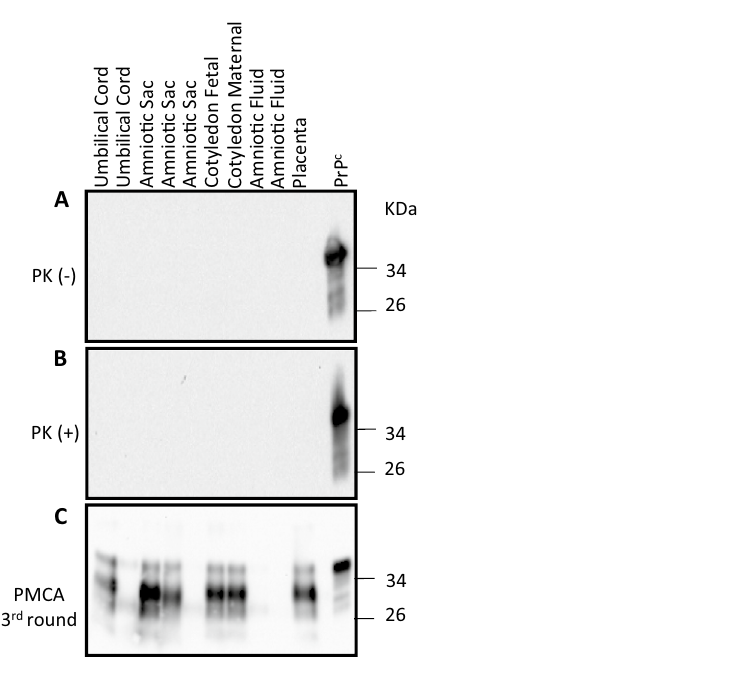
Figure 2. Identification of PrP Sc in white-tailed deer gestational tissues and fluids by western blot and PMCA. Western blot analysis of representative gestational tissue samples prior ( A ) and after ( B ) PK treatment. ( C ) PMCA results from the same representative samples depicted in ( A ) and ( B ) after three PMCA rounds. Numbers at the right of each panel represent molecular weight markers (in KDa). “PrP C ” denotes brain extracts from Tg1536 mice not treated with PK and used as additional molecular weight